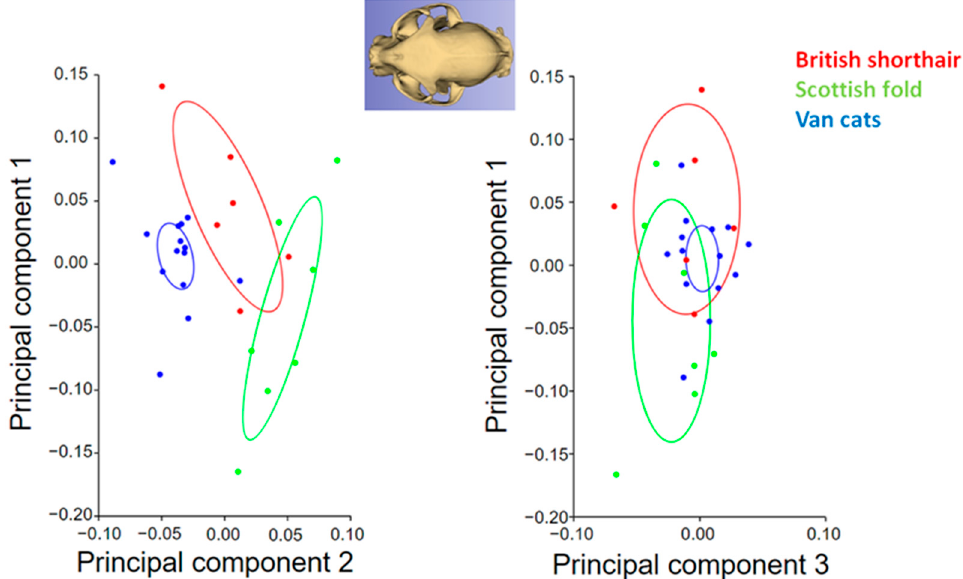
Figure 4. Principal component analysis scatter plot comparing skull morphology of cat breeds (dorsal view). Ellipses represent 95% confidence intervals around the means.